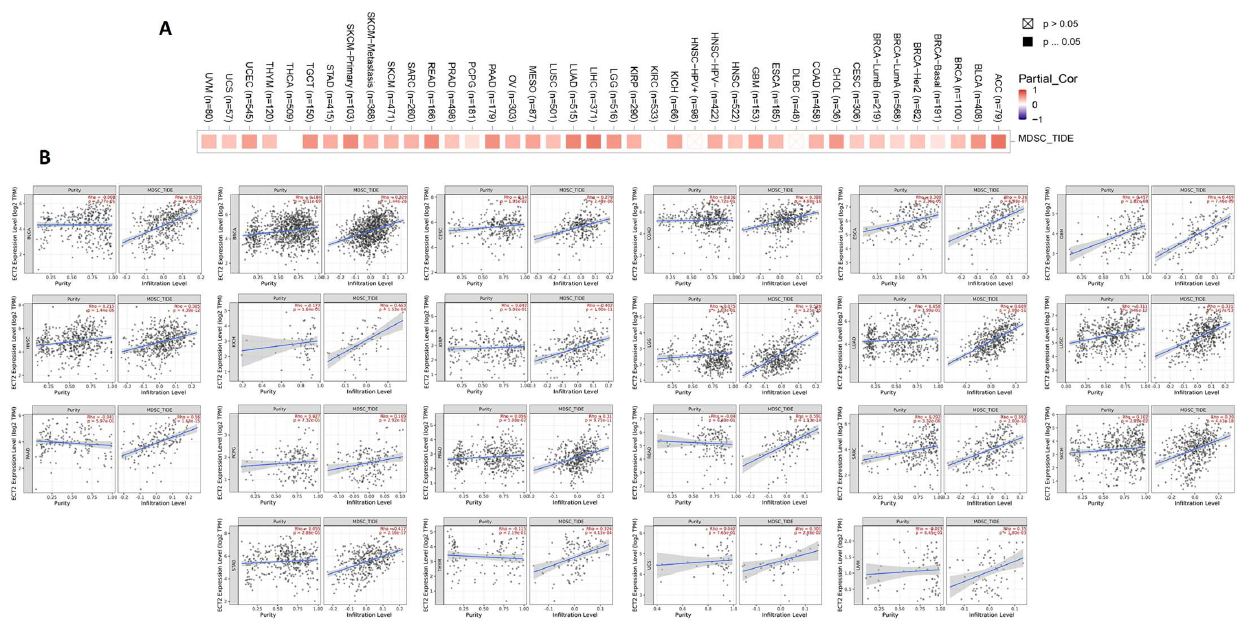
Figure 8. ( A ) The correlation between ECT2 expression level and infiltration of myeloid-derived suppressor cells (MDSC). ( B ) Scatter plots that demonstrate the correlation between the expression of ECT2 and the infiltration level of MDSC.